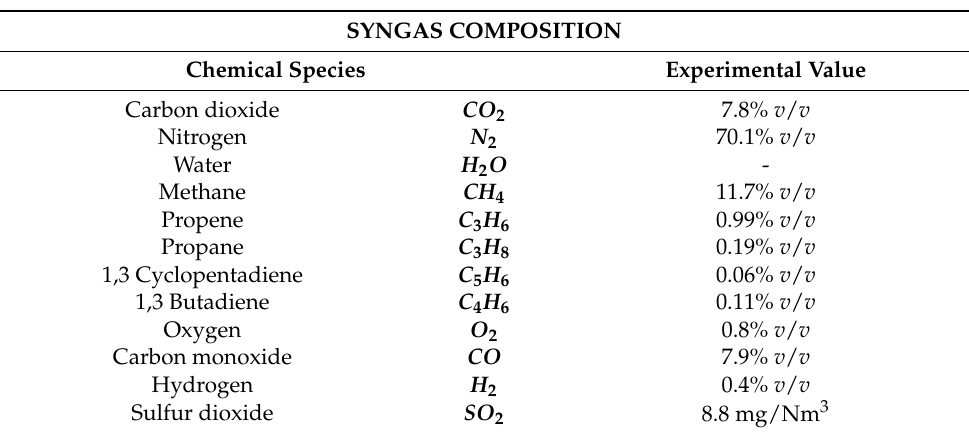
Table 2. Composition of the produced syngas.